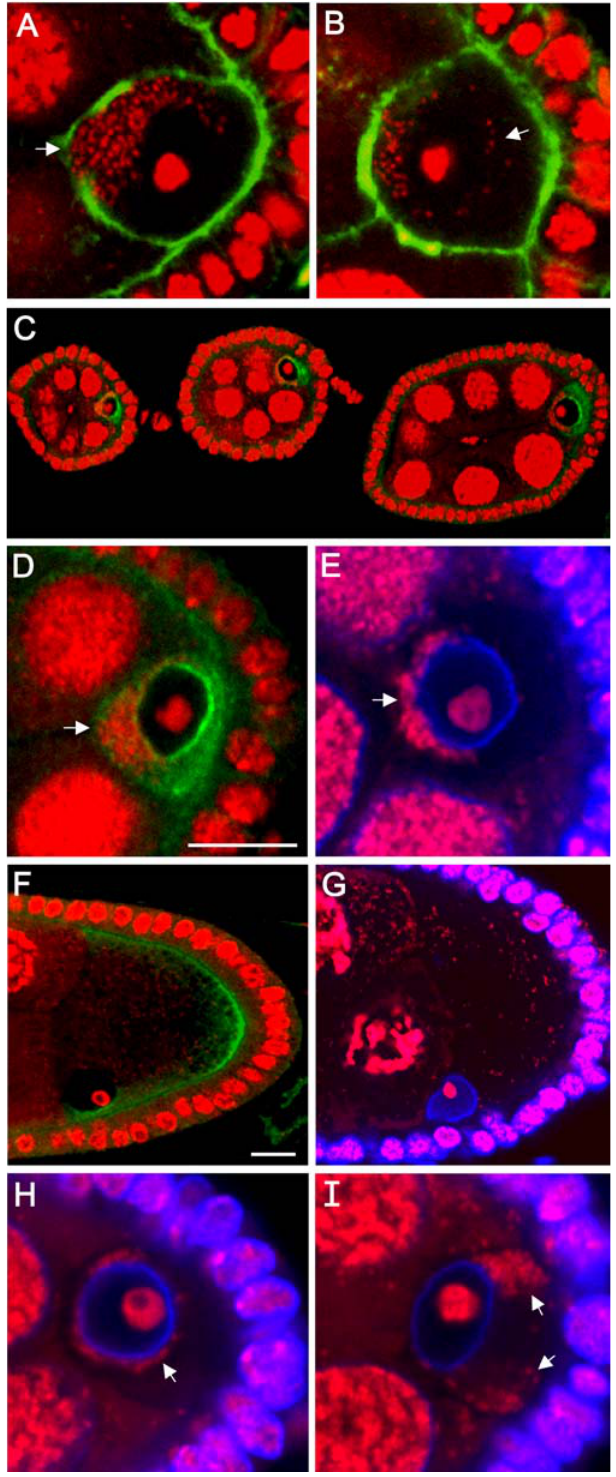
Figure 8. In the Oocyte, Wolbachia Localize along the Anterior Nuclear Envelope In (A) and (B), Wolbachia and host DNA are red (propidium iodide), and cell cortex and ring canals are green. In (C), (D), and (F),) cytoplasmic Dynein is green, and Wolbachia and host DNA are red (OliGreen). In (E) and (G–I), nuclear envelope is blue, and Wolbachia and host DNA are red (OliGreen). White arrows indicate Wolbachia . (A) A stage 7 oocyte derived from a hs-Dmn/ þ female, heat shocked. Wolbachia localize normally in the anterior